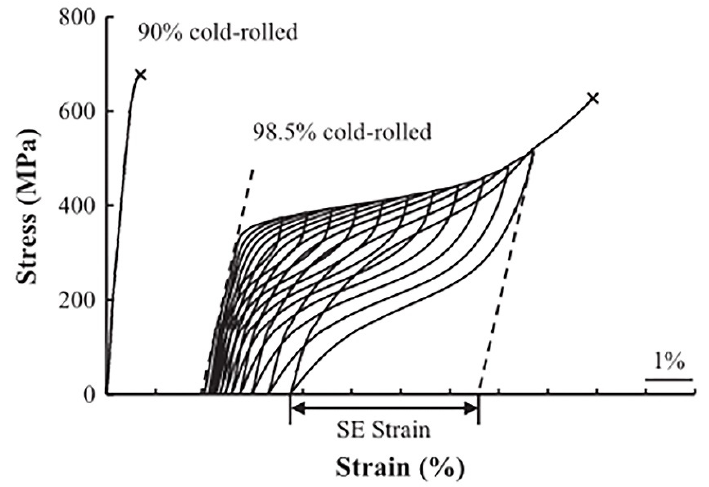
Figure 14. Tensile curves of FeNiCoAlTiB alloy after 90% and 98.5% cold-rolling [69]. Reprinted with permission from Ref. [69]. Copyright 2014 Elsevier.